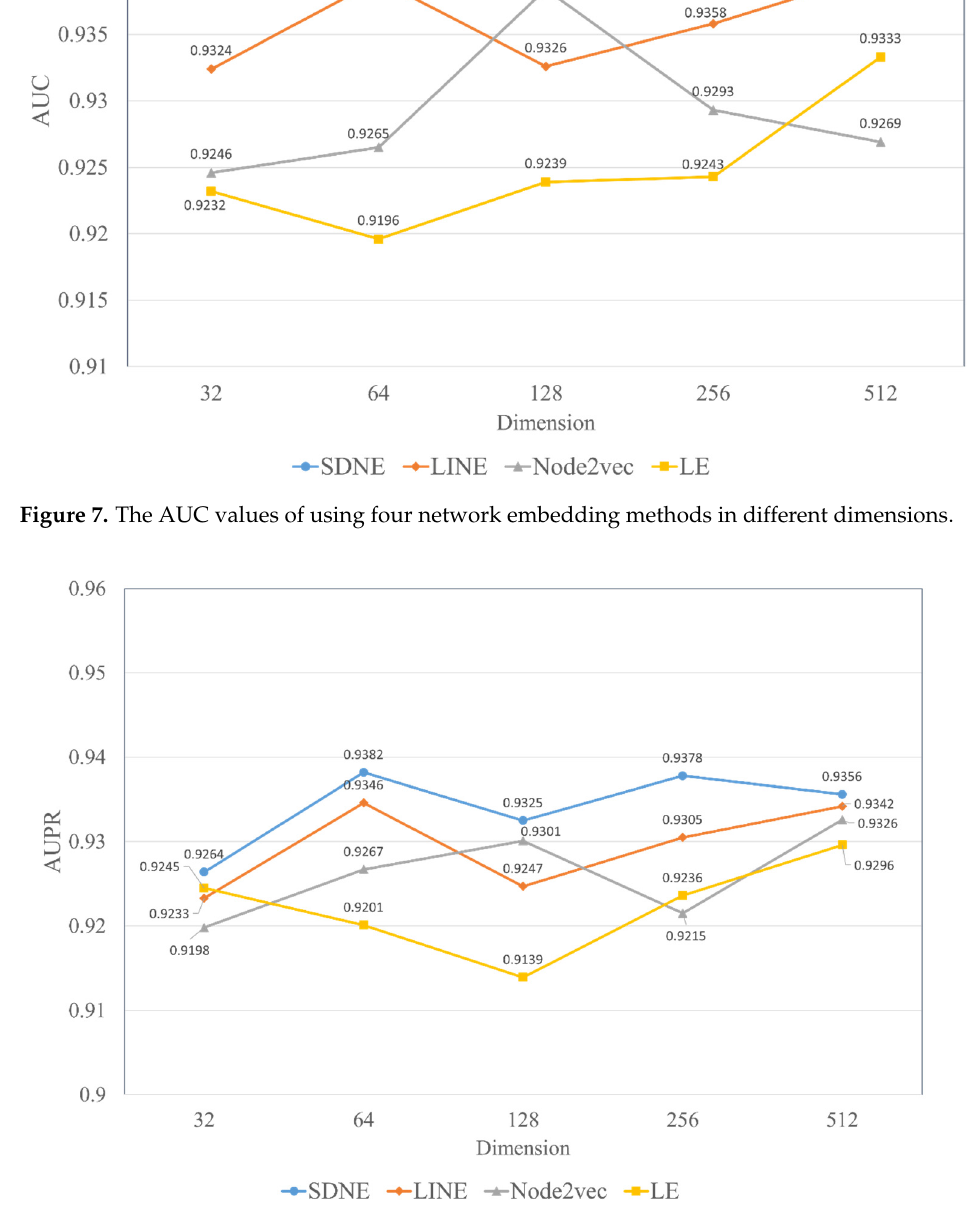
Figure 8. The AUPR values of using four network embedding methods in different dimensions.